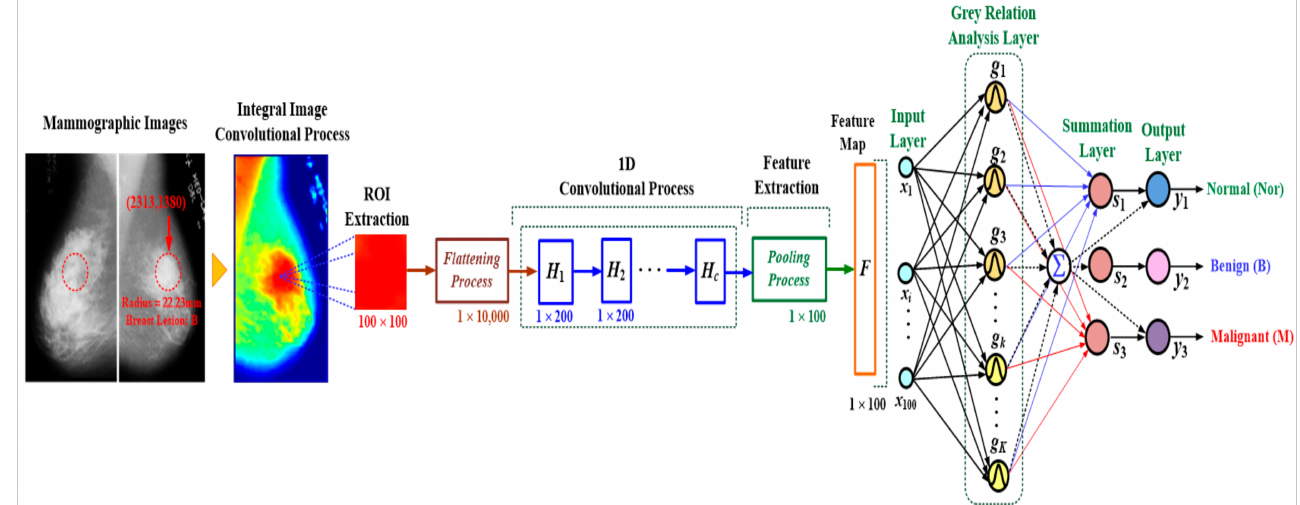
Figure 4. Structure of the proposed two-dimensional spatial and one-dimensional CNN-based classifier.